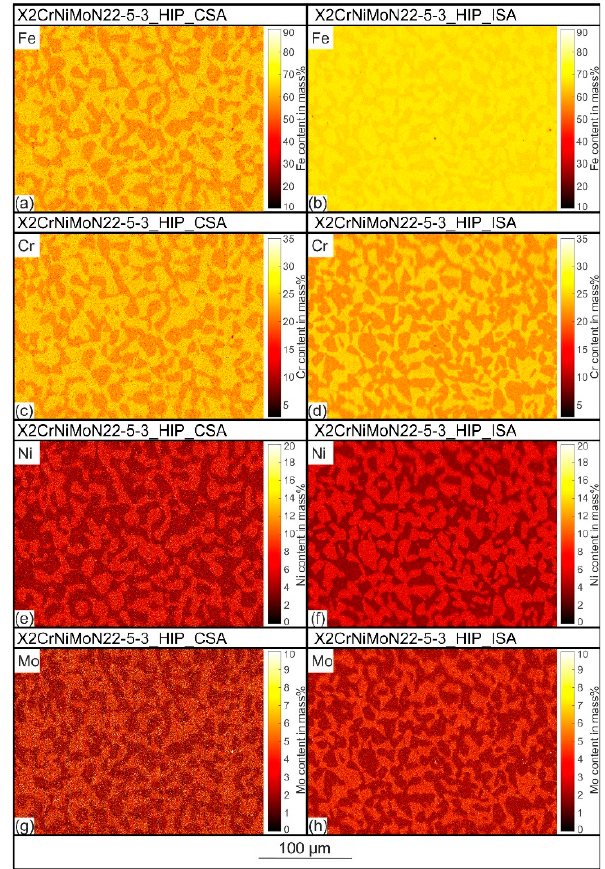
Figure 5. Element distributions of the X2CrNiMoN22-5-3_HIP+CSA ( a , c , e , g ) and X2CrNiMoN22-5- 3_HIP_ISA steels ( b , d , f , h ) determined by EDS.